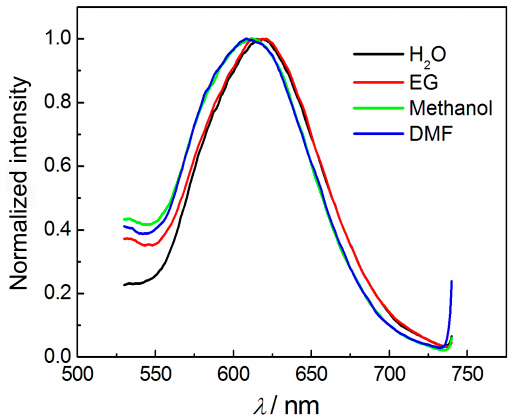
Figure 5. The effect of four different solvents on the luminescence wavelength of AuNCs, including water, ethylene glycol (EG), methanol, and N,N -dimethylformamide (DMF).